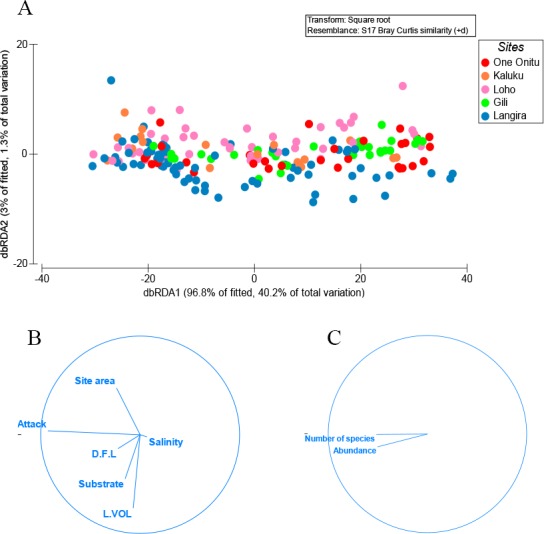
Multivariate ordinations of animal abundance, numbers of species and environmental variables across five mangrove forests.Distance-based redundancy analysis (dbRDA) expressed as ordinations. (A) the variation of teredinid-attacked wood samples analysed from five mangrove sites in, relation to; (B) measured environmental variables: teredinid-attack (attack), site area, distance from land (D.F.L), substrate type, volume of wood sample (L vol) and salinity. The strongest relationship explaining the scatter of wood samples is correlated with teredinid attack, and (C) a strong relationship is found with the number of species and abundance of animals found in the wood samples with teredinid attack.